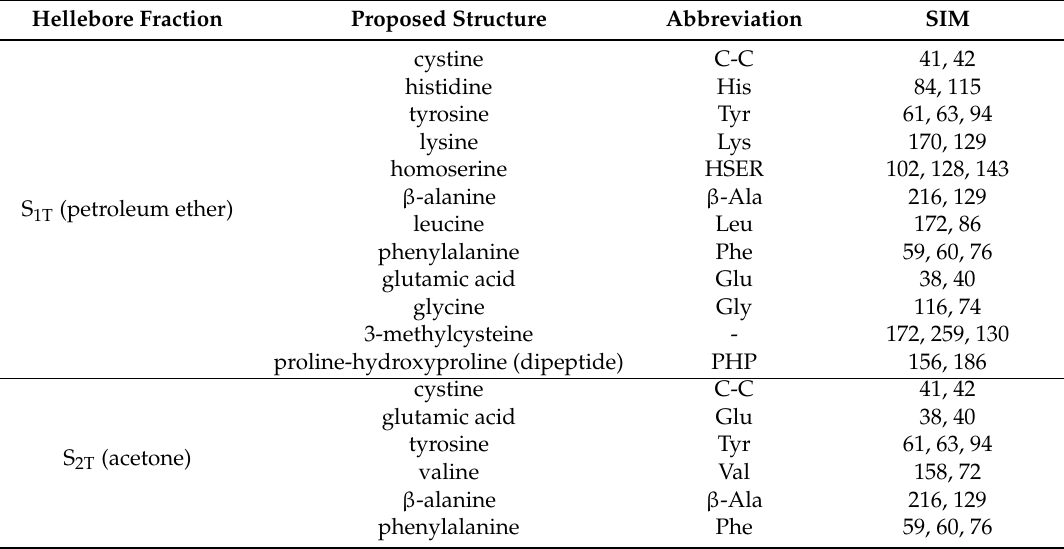
Table 3. Thionin GC-MS identification.